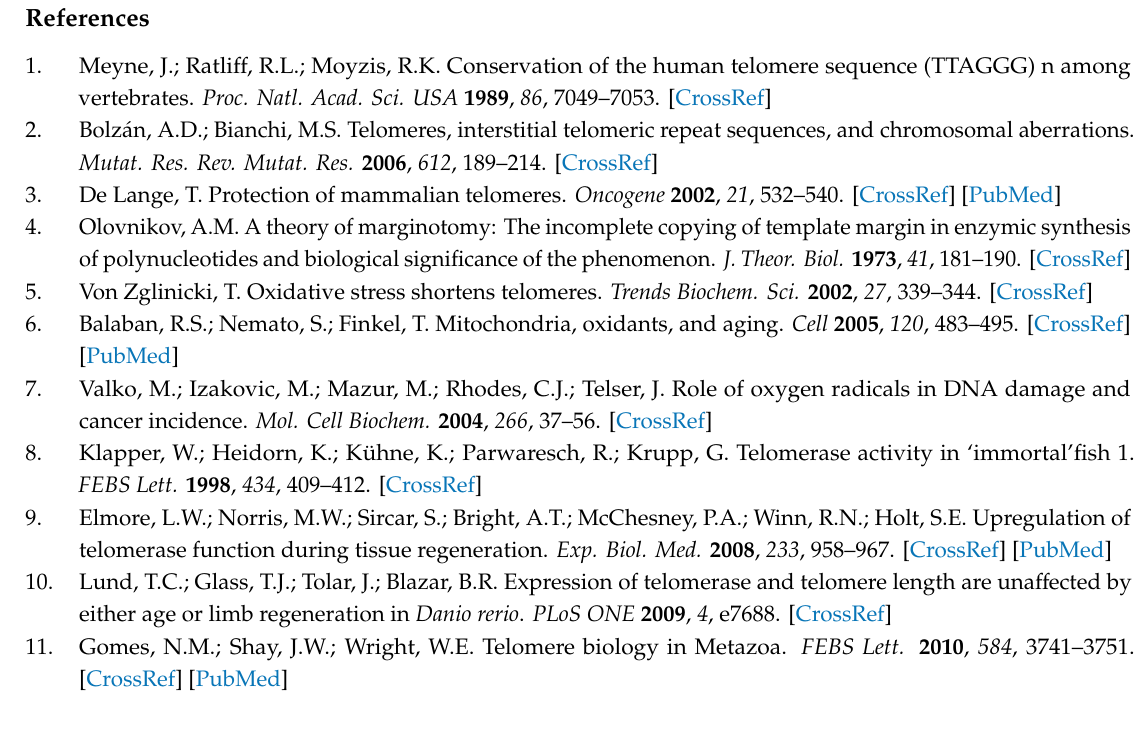
Table S1: Telomere length related fluorescence of all examined diploid and triploid rainbow trout specimens (averages and standard